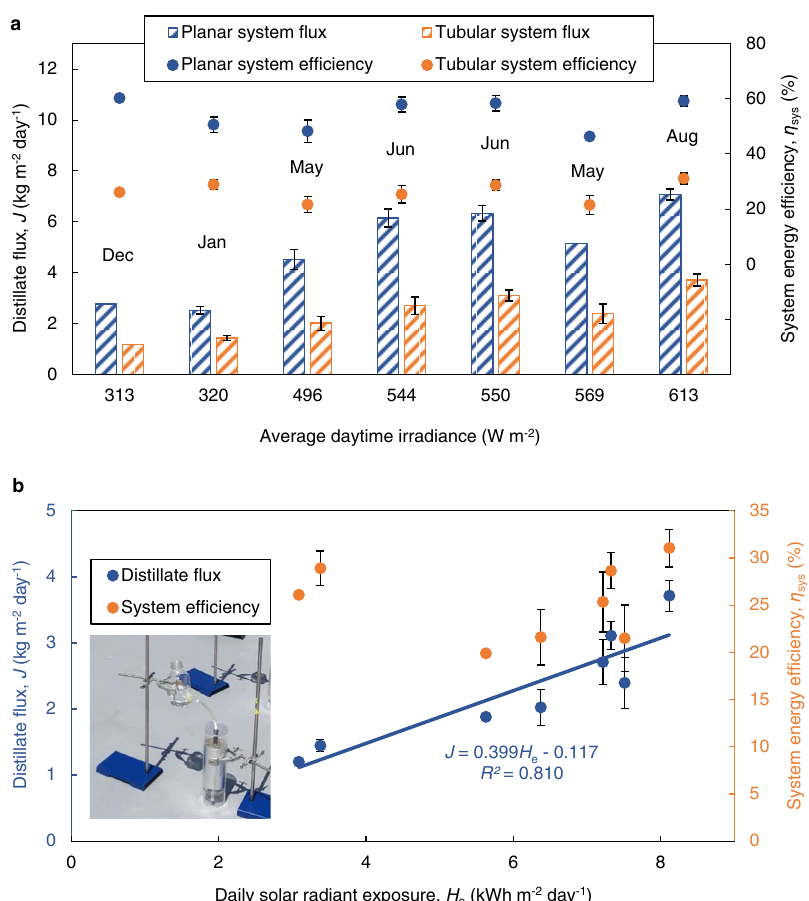
Fig. 3 The performance of single-stage tubular systems under natural sunlight. a Distillate production rates of tubular systems per unit area of black membrane (i.e., distillate fl ux, J ) and the system energy ef fi ciencies, ƞ sys , under natural sunlight (from sunrise to sunset) in various months of a year at different solar irradiances, in comparison with that of planar systems at 30° inclination to the ground. Both systems had the same membrane dimensions (i.e., 50 mm × 50 mm). The data of single-stage planar systems were copied from Fig. 1a for convenient comparison with tubular systems. b Distillate fl uxes and system energy ef fi ciencies of tubular systems with respect to daily solar radiant exposure, H e , calculated based on the global horizontal irradiance. The surface density of carbon black NPs on the permeate side of PVDF membrane (pore size: 0.45 µm) was 7.5 – 7.9 g m − 2 and the hydrostatic pressure on the center of the membrane was 90 – 105 mmH 2 O (i.e., 0.88 – 1.03 kPa) for both tubular and planar systems, as shown in Supplementary Table 3. DI water was used as feedwater in the experiments, and the temperature of feedwater was between 22 and 36 °C. Variations in irradiance and weather condition can be found in Supplementary Table 1. The error bars represent the standard deviations of duplicate results obtained using two different systems on the same 0.45 µm and dimensions of 50 mm × 50 mm. Thus, the tubular penetrate the membrane tube and the inside of the membrane membrane has a diameter of 16 mm and a height of 50 mm. The tube is essentially a feedwater chamber. The outer surface of the distillation chamber of the tubular system has an inner diameter membrane tube was coated with carbon black nanoparticles, of 70 mm and a height of 50 mm, which gives about the same which absorbed solar radiation and converted the radiation to volume (difference within 2%) as the distillation chamber of the heat. The heat was transferred through conduction 24 to the planar system. Therefore, the water vapor had the same room to feedwater that partially entered the capillary pores of the fl ow into the condensation chambers in both systems. The acrylic membrane from the inside of the membrane tube. Thus, the glass tube also has the same thickness (1/8 inch) as the distillation feedwater was effectively evaporated through interfacial heating. chamber of the planar system. The condensation chamber of the Upon evaporation, water vapor passed through the pores of the tubular system has an inner diameter of 70 mm and a height of membrane and entered the tubular transparent distillation 158 mm. The inner surface areas of the condensation chambers in chamber that contained the membrane tube and the steam. both systems were about the same (difference within 2%) on The outer surface of the condensation chamber was covered by a which the water vapor condensed to distilled water. Other re fl ective heat barrier that re fl ected the sunlight and helped keep experimental details such as surface density of carbon black on the inside of the chamber cool where water vapor condensed into the permeate side of membranes, hydrostatic pressure at the distilled water. The tubular system was set vertically so that the center of membranes, and feedwater (i.e., DI water) temperature distilled water was collected at the bottom of the system. for both systems are presented in Supplementary Table 3. The The performance of the tubular system was compared with the variation of solar irradiance during experiments can be found in single-stage planar system after they were tested simultaneously Supplementary Table 1. under natural sunlight from sunrise to sunset at the same As presented in Fig. 3a, the ƞ sys and the distillate production locations. The two systems used the same type and size of membrane, i.e., PVDF membrane with a nominal pore size of rate per unit area of membrane (i.e., distillate fl ux) of the tubular